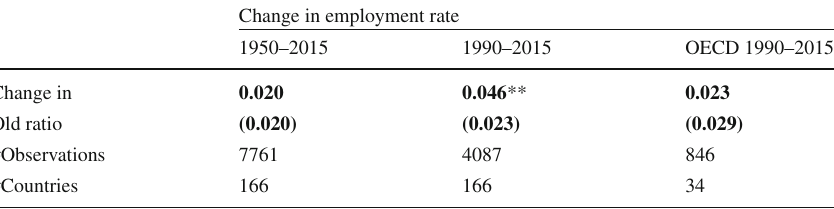
Table 2 Population ageing and employment